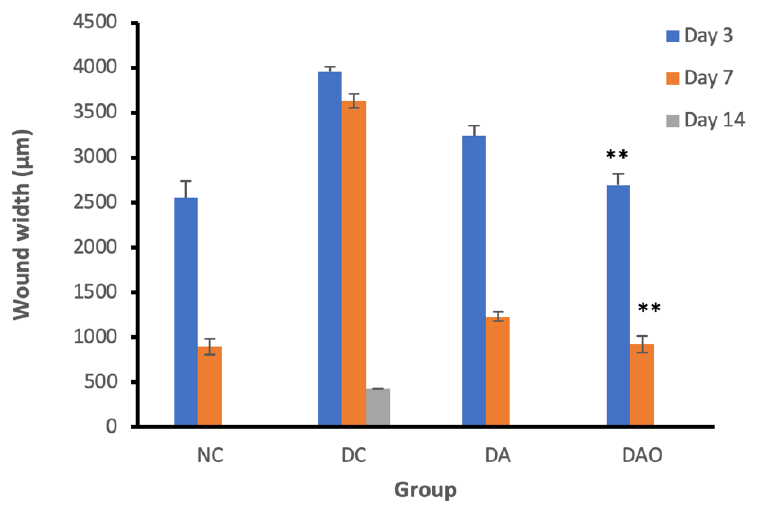
Figure 5. Graph of the wound width parameters. Notation on the graph shows the result of the statistical test (α < 0.05). (**) notation shows insignificant differences with NC, but significant differences with DC. ** = α ≤ 0.01. NC—normal control group; DC—diabetic control group; DA—alginate treatment group; DAO—treatment of alginate–okra fruit extracts. All groups have three variation times.